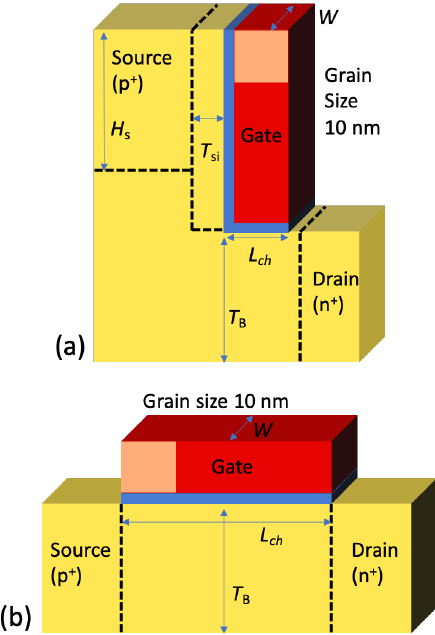
Figure 1. Schematic diagram of ( a ) the L-shaped tunnel field-effect transistor (TFET) and ( b ) the planar TFET. The L-shaped TFET features a vertical- band-to-band tunneling (BTBT) (parallel to the gate-field direction) in the intrinsic Si layer. Table 1. Device parameters of devices used for technology computer-aided design (TCAD) simulation.